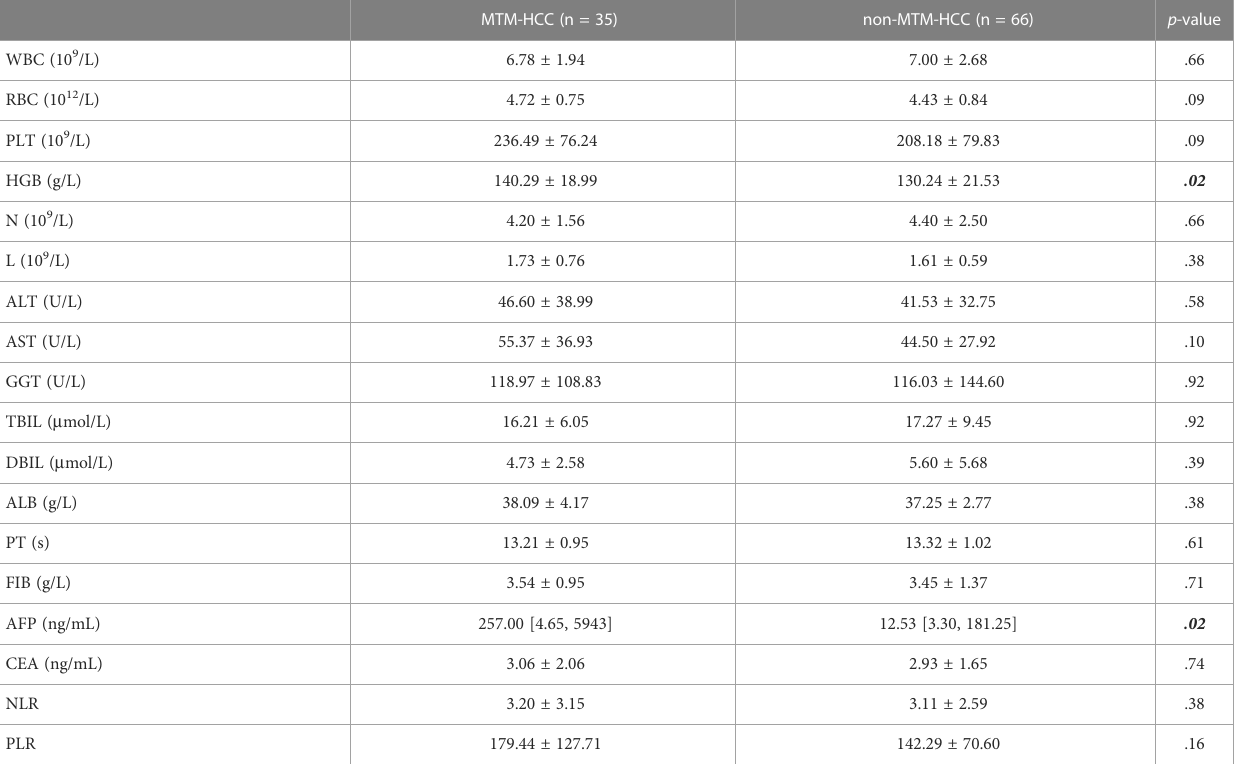
TABLE 2 Comparison of the laboratory characteristics of MTM-HCCs and